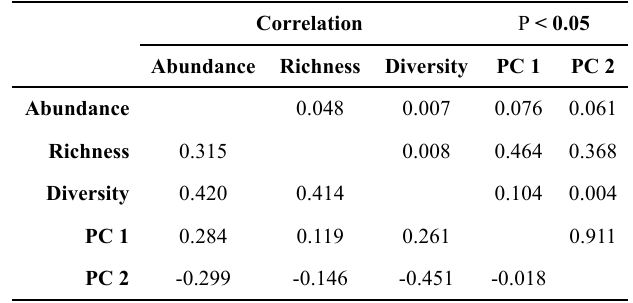
Table 4 . Pearson correlation matrix among abundance, richness and diversity of species of ants and the values of the two axes of a Principal Components Analysis (PCA).The numbers represent the r values of linear correlation between variables. The P values indicate the level of significance of the correlation (P